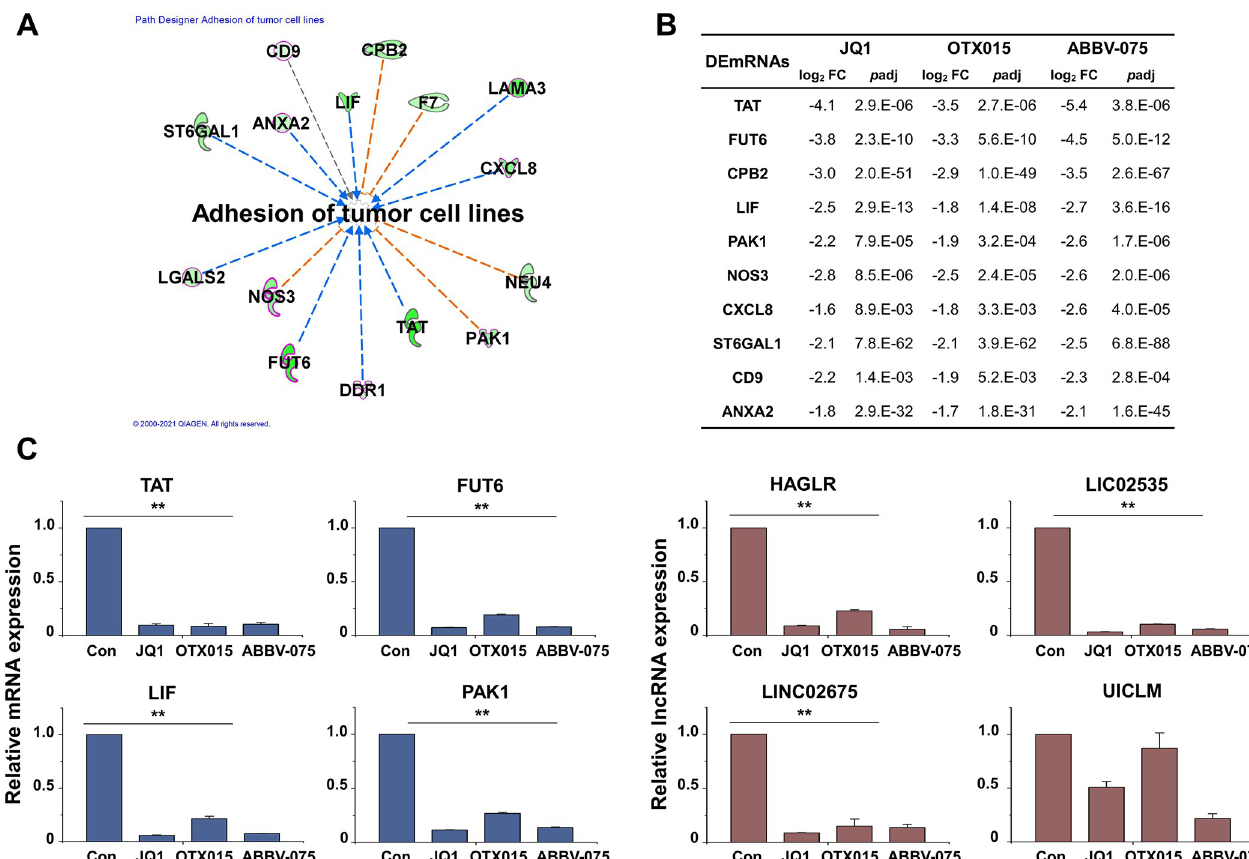
Fig 8. Biofunctional analysis of DEmRNAs related to adhesion of tumor cell lines. (A) IPA downstream effects analysis showing the mapping of most significant genes related to adhesion of tumor cell lines from the results of the biofunctional analysis in Module 1. Of the genes related to adhesion of tumor cell lines, only metastasis-related genes are shown in bold and red. (B) Log 2 fold changes and p adj in the expression of genes related to adhesion of tumor cell lines. (C) Expression levels of adhesion-related mRNAs and lncRNAs were analyzed by qRT-PCR and normalized to GAPDH or U6 transcript levels, respectively. Overall, the adhesion-related mRNAs and lncRNAs were inhibited by BET inhibitors. The data represent three independent experiments. The values are the mean ± SD of triplicate experiments ( �� p < 0.01).